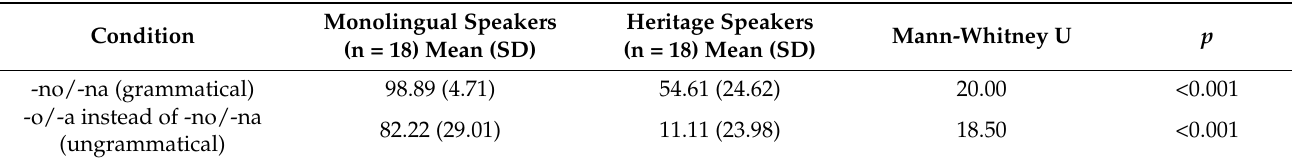
Table 3. Morphological shape: Mean accuracy rate, standard deviation (SD), statistical significance (adapted from (Rinke and Flores 2014, p.